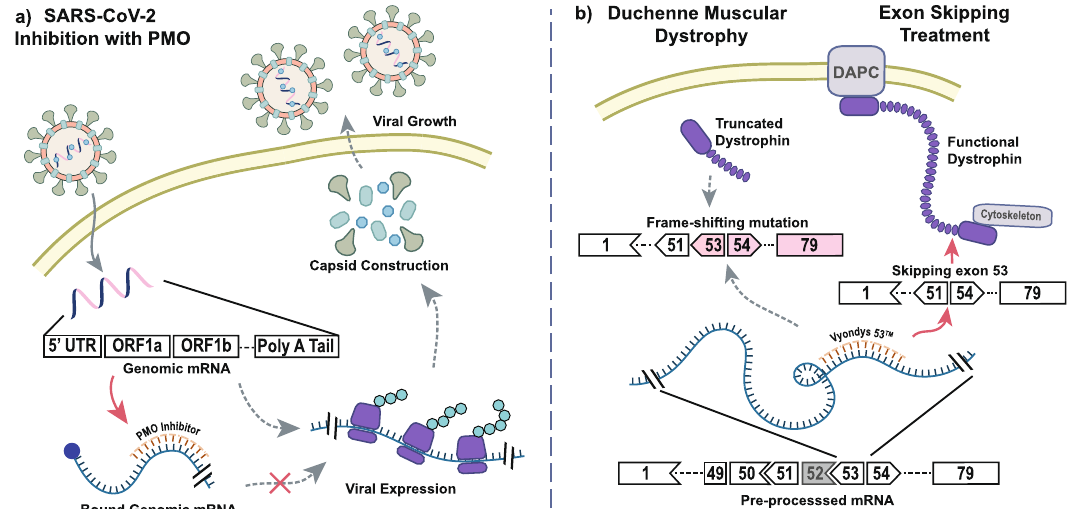
Fig. 2 Antisense PMO therapeutics are adaptable to a range of disease types. a An antisense PMO binding to the 5 ′ UTR of the SARS-CoV-2 genomic transcript can prevent expression of viral genes and subsequently inhibit viral growth. b Dystrophin is an integral membrane protein that anchors the cytoskeleton to the muscle cell membrane via the dystrophin associated protein complex (DAPC). Little to no natural dystrophin is produced in patients with Duchenne muscular dystrophy (DMD). The PMO Vyondys 53 ™ induces skipping of exon 53 to regain the proper reading frame, producing shorter but functional dystrophin.